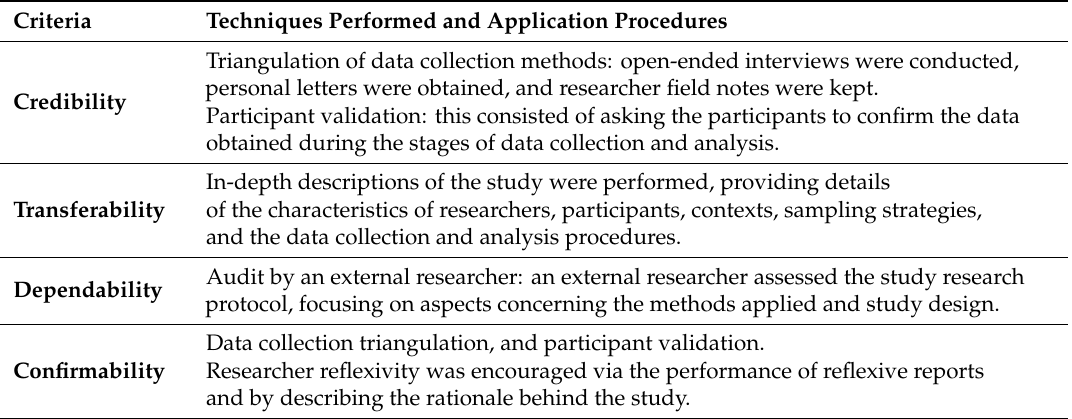
Table 1. Trustworthiness